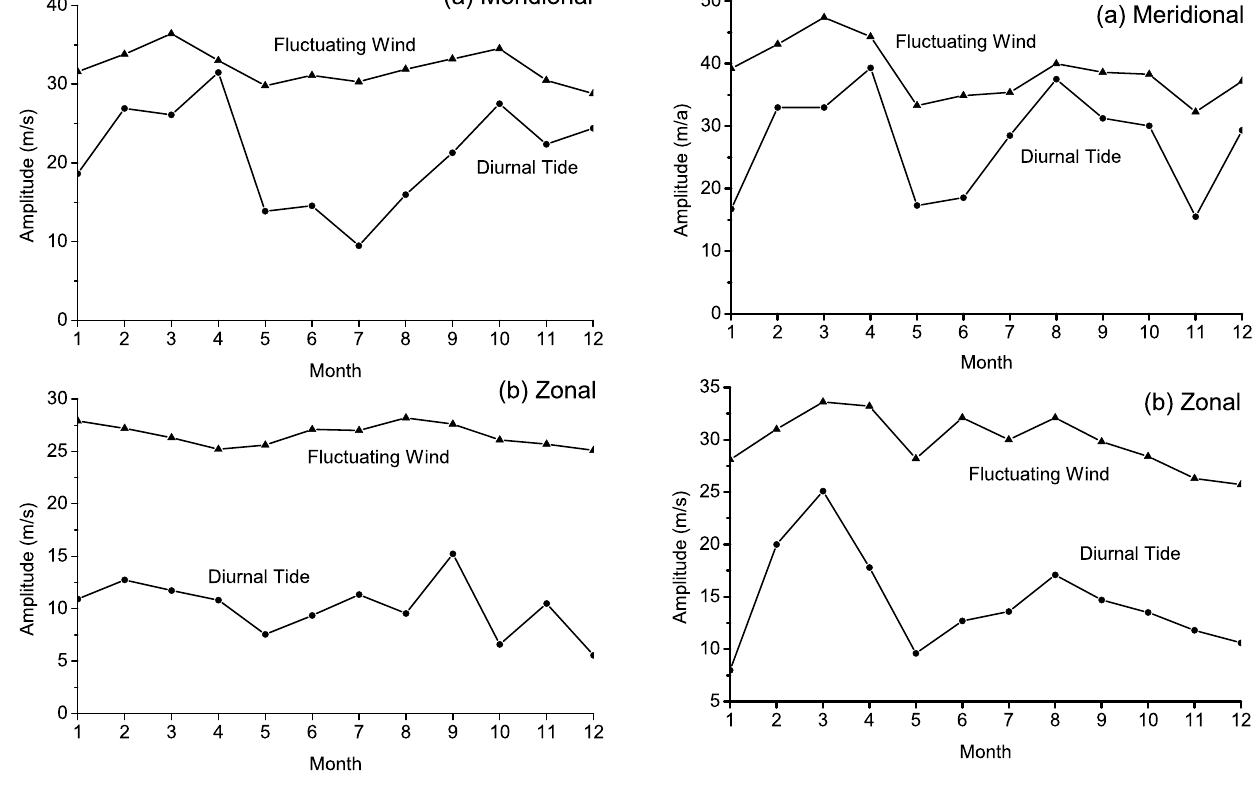
Fig. 3. (a) Monthly means of meridional fluctuating wind velocity and the diurnal tidal amplitude for S˜ao Jo˜ao do Cariri, 2005; (b) As for (a) but zonal winds.